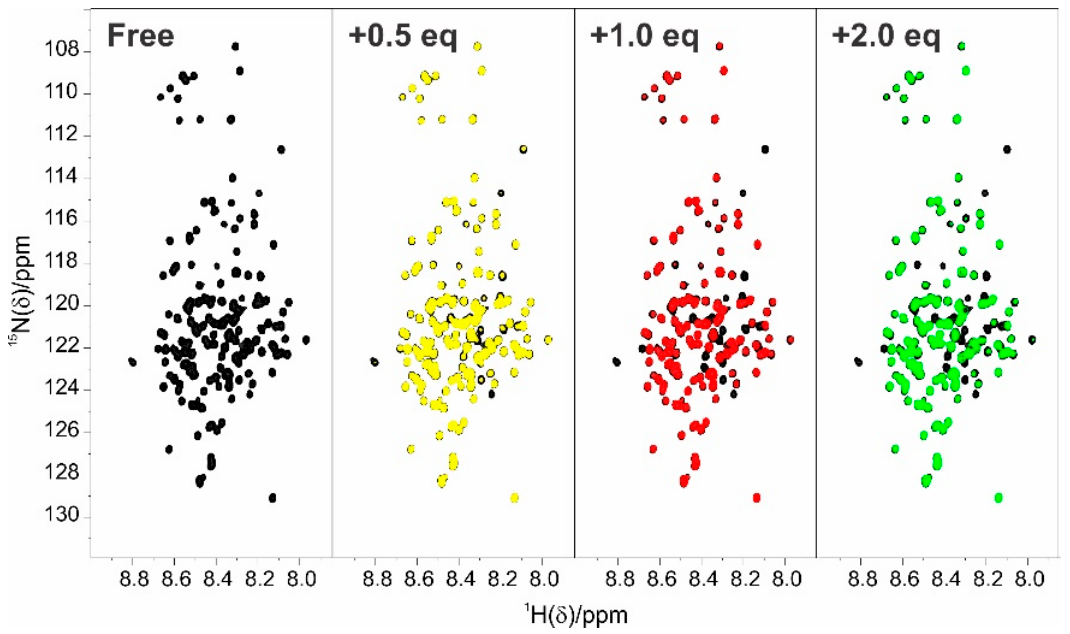
Figure 6. Titration of CBP-ID4 with E1A12S followed by 1 H- 15 N FHSQC experiments. CBP-ID4 (black); CBP-ID4:E1A12S at 1:0.5 molar ratio (yellow); CBP-ID4:E1A12S at 1:1 molar ratio (red); and CBP-ID4:E1A12S at 1:2 molar ratio (green). All the experiments were acquired at 283 K, using a 22.3 T Bruker Avance III NMR spectrometer equipped with a TCI CryoProbe TM .